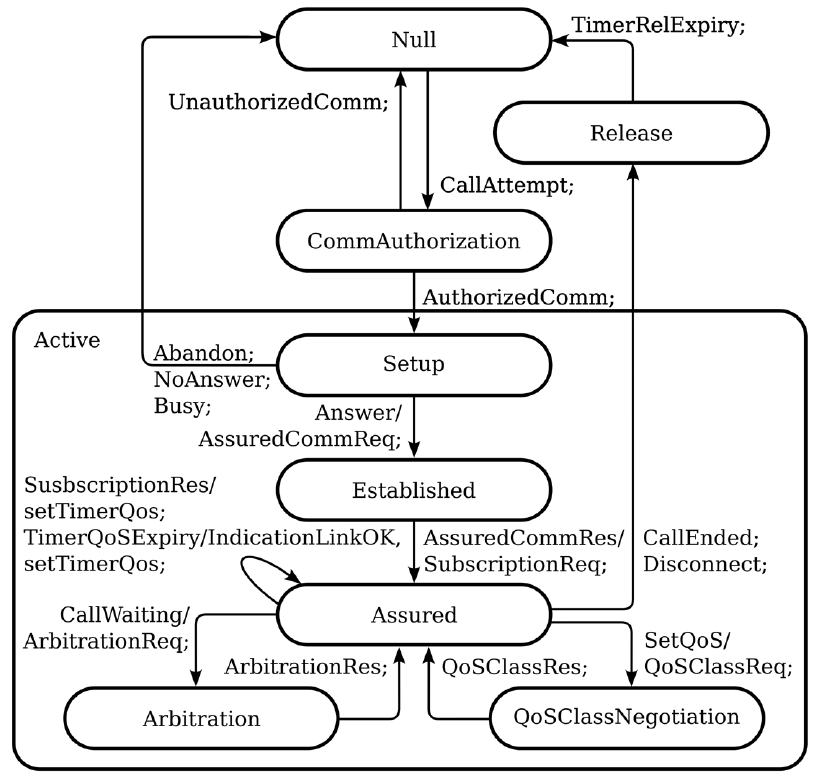
Figure 15. Critical application view on the state of the originating call leg.